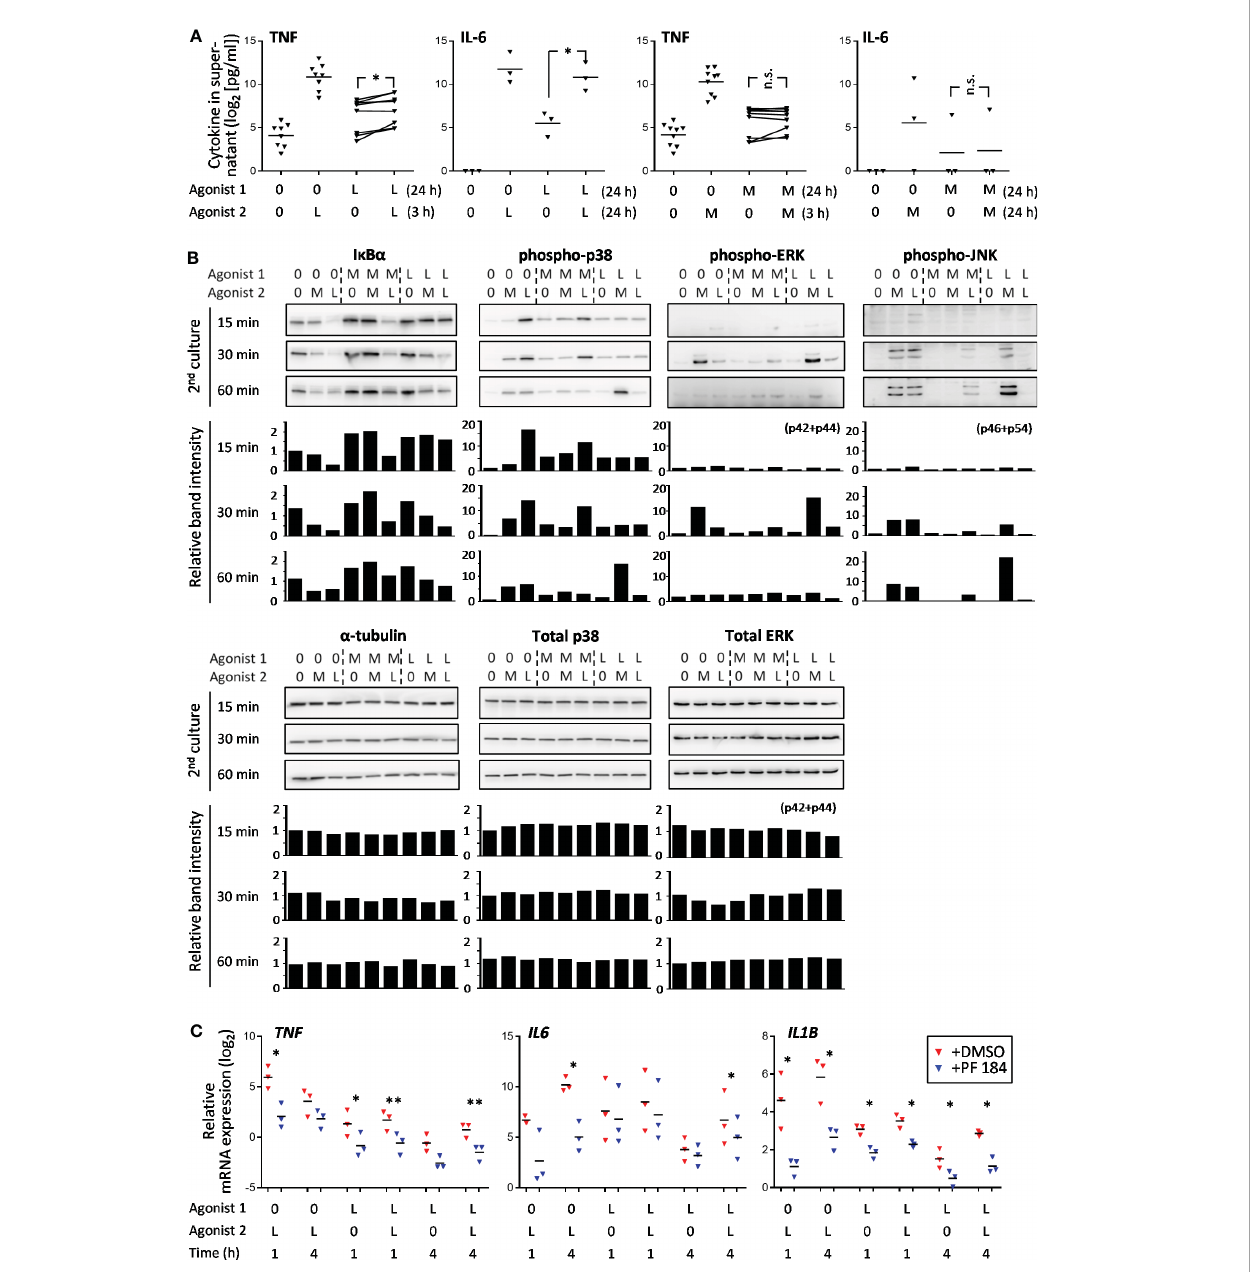
FIGURE 6 Activation of NF- k B and p38 pathways in naïve, M-triDAP- and LPS-tolerized macrophages after their reculture with medium (0), M-triDAP (M) or LPS (L). (A) Levels of TNF and IL-6 in macrophage supernatants after indicated stimulation sequences (3 to 9 experiments). Statistical analysis by repeated measures ANOVA with Tukey correction. * p < 0.05, n.s. = non-signi fi cant. (B) Immunoblotting for I k B a , phospho-p38, phospho-ERK1/2, phospho-JNK, total p38, total ERK1/2 and a -tubulin at indicated time points after 2 nd stimulation (one representative Western blot out of three) and corresponding densitometry data normalized to untreated macrophages at 15 min. (C) Effect of I k B kinase inhibitor on TNF , IL6 and IL1B mRNA expression in naïve and LPS-tolerized macrophages (RT-PCR). Cells were cultured without or with LPS for 24 h, washed, incubated without or with PF 184 (5 m M) for 15 min, whereafter recultured without or with LPS for 1 or 4 h. 3 experiments, bars denote means. *p < 0.05, **p < 0.01 for comparisons between cells treated or not with PF 184 in identical stimulation conditions (paired